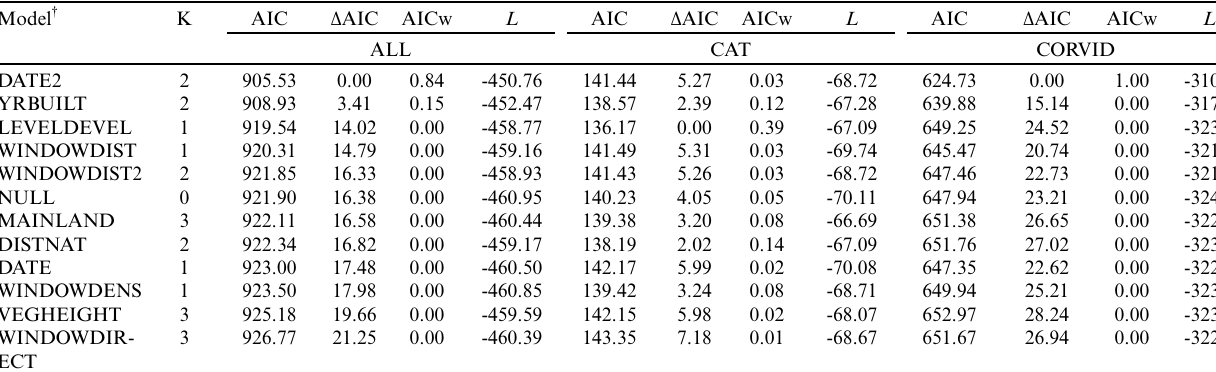
Table 4 . Akaike information criterion (AIC) scores for each model considering the covariates that affected carcass removal by scavengers at houses. The summary also includes the relative difference between models and the best model ( Δ AIC), Akaike weights (AICw), log- likelihood (L), and number of parameters (K). All tests were run using all scavengers, and again using removals by corvids and cats separately, the two groups of scavengers that were the most common.